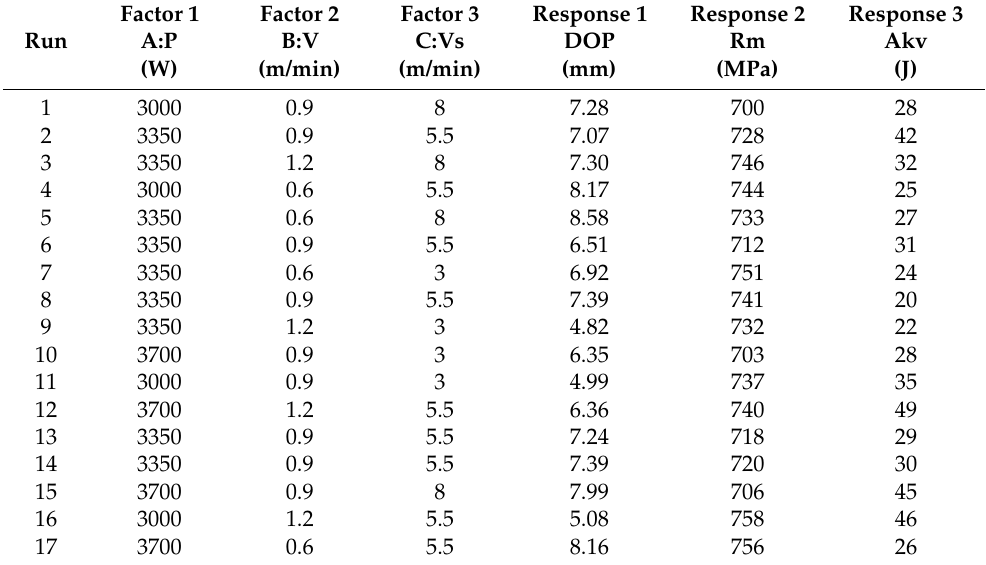
Table 5. Experimental design matrix and the measured responses.